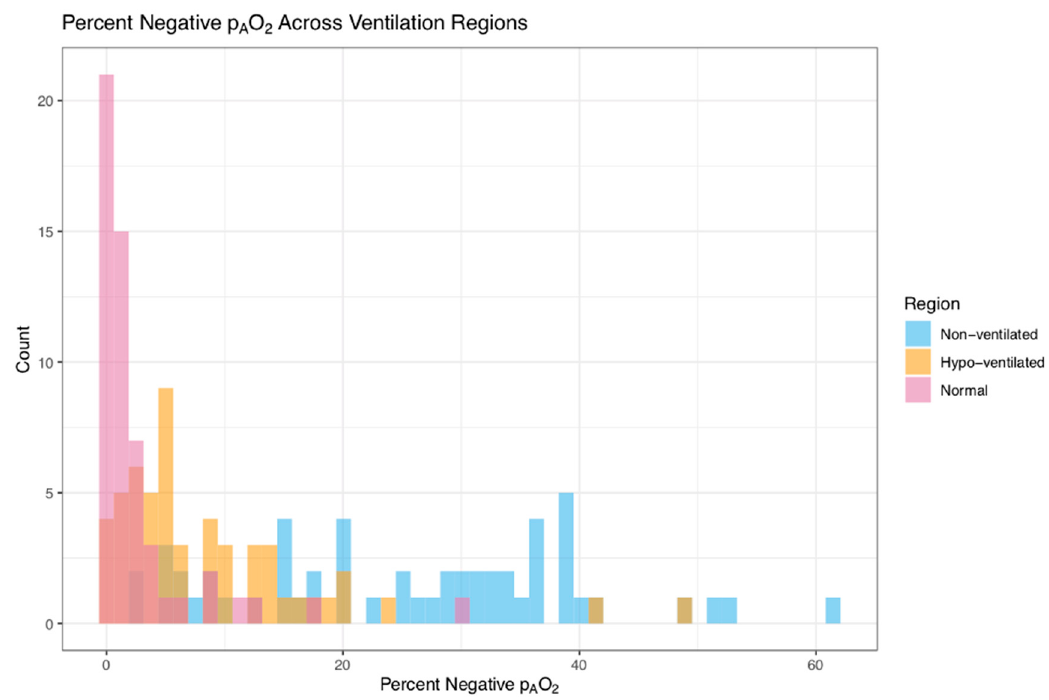
Figure 4. Average percent negative p A O 2 per subject in normal, hypo-, and non-ventilated for a single subject.